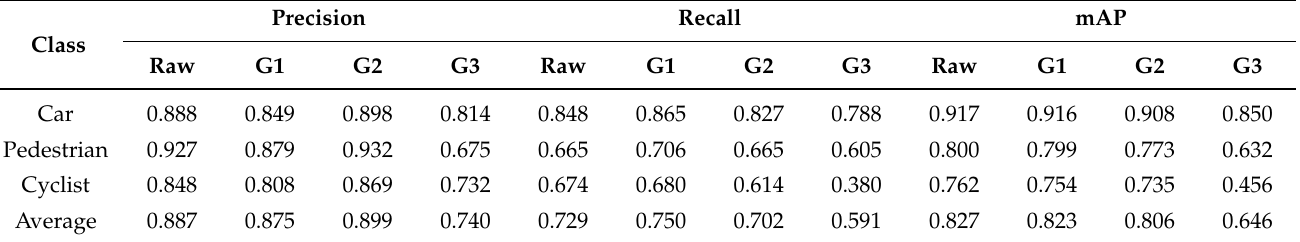
Table 6. Evaluation metrics for KITTI point cloud data compressed at different degrees, converted with the Bilateral Filter method and evaluated using the best YOLOv5m model. The resulting model, with the best weights, was obtained over the course of 200 epochs, with a batch size of 20.